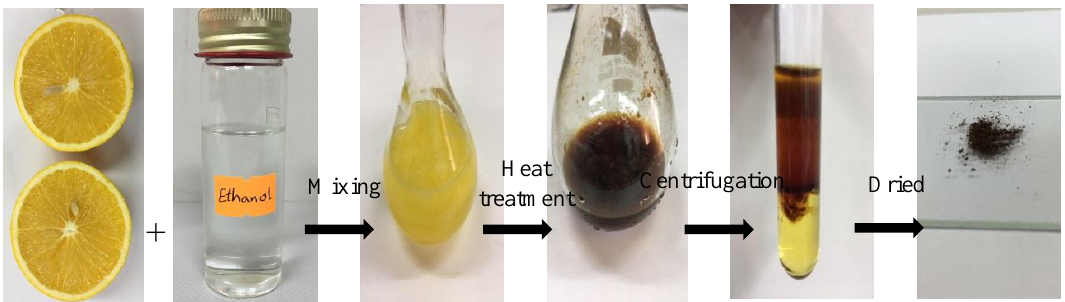
Fig.2: The steps of produced carbon dots